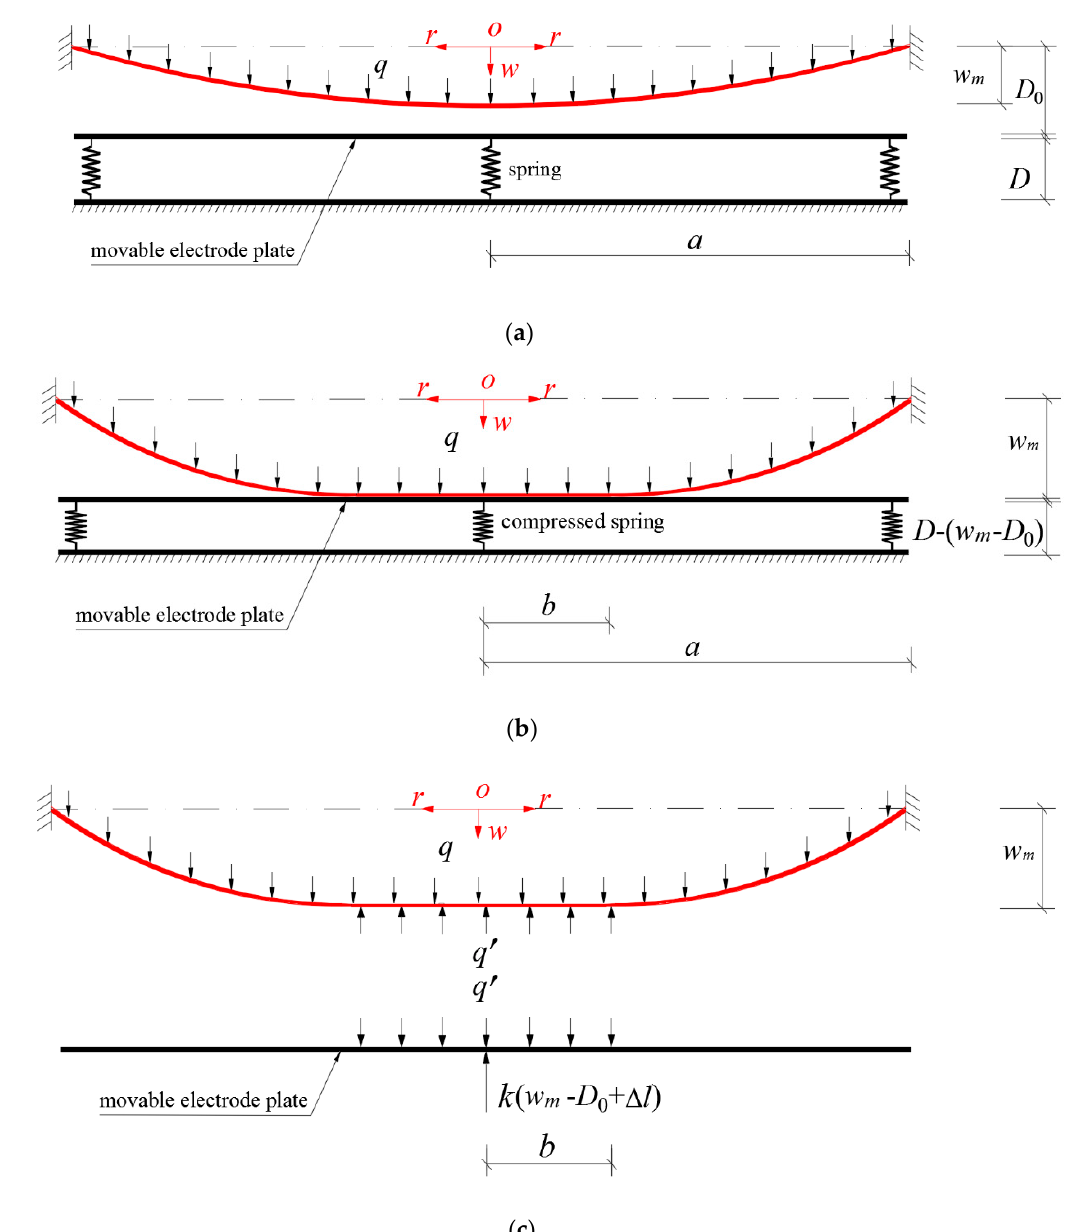
Figure 2. Sketch of the contact problem between wind-driven circular membrane and spring-driven frictionless rigid plate: ( a ) non-contact state between membrane and plate; ( b ) contact state between membrane and plate; ( c ) anatomical view of interaction force between deflected membrane and spring-driven plate.